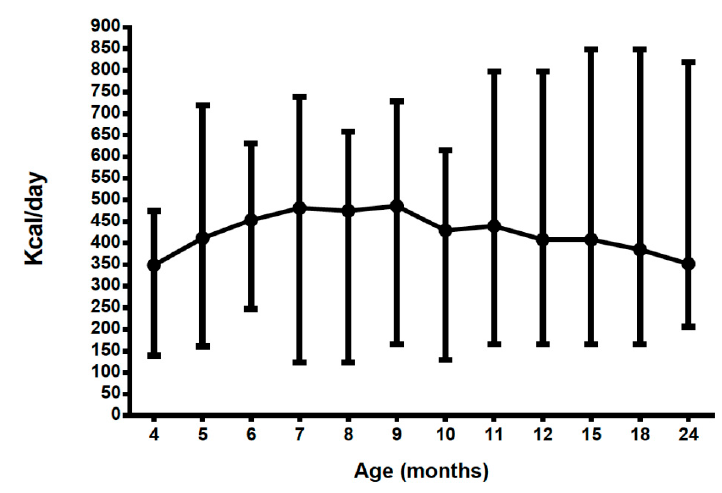
Figure 7. Mean energy intake (kcal) from both protein substitutes (infant and weaning) by age. 3.7. Total Energy Intake PKU vs. Control (Includes Energy Intake from Food) There was no significant difference between PKU and control groups for total energy intake or total energy intake as a percentage of dietary reference values (DRV) [25] longitudinally or at any age (Figure 8; Tables S9 and S10). There were also no gender differences either within or between groups.